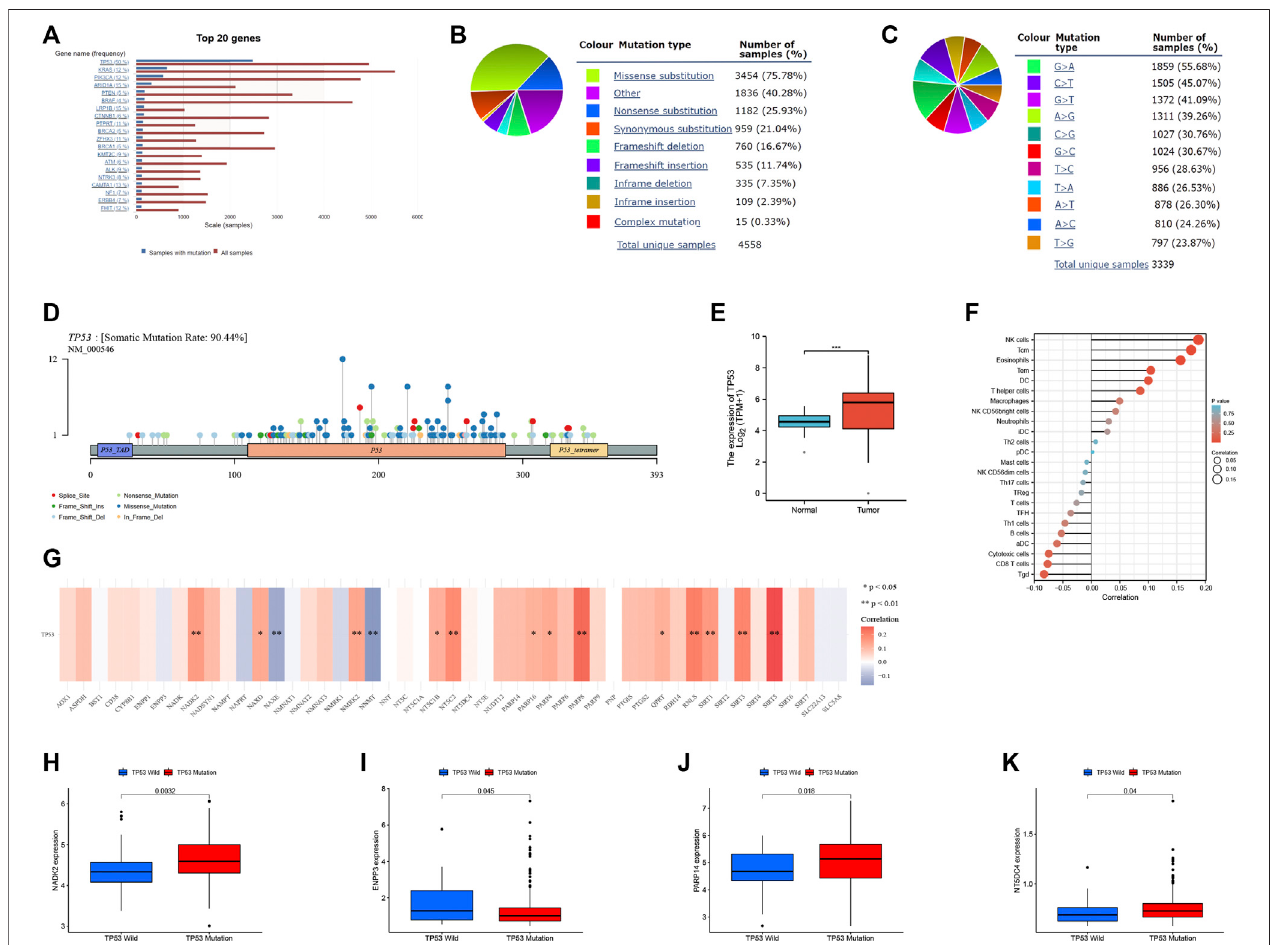
FIGURE 3 | Analysis of the relationship between TP53 and NMRGs. COSMIC database analysis of OC mutation distributions (A) and its types (B, C) . (D) Lollipop charts of the mutated TP53 gene, the fi gure caption shows the somatic mutation rate, and the subheadings shows the name of somatic mutation. (E) TP53 was signi fi cantly overexpressed in the tumor group. (F) The relationship between TP53 and immune in fi ltrating cells. (G) Relationship between TP53 and NMRGs. (H – K) Differences in the expression levels of NMRGs between the TP53 mutant group and the wild-type group. * p < 0.05, ** p < 0.01, *** p < 0.001.